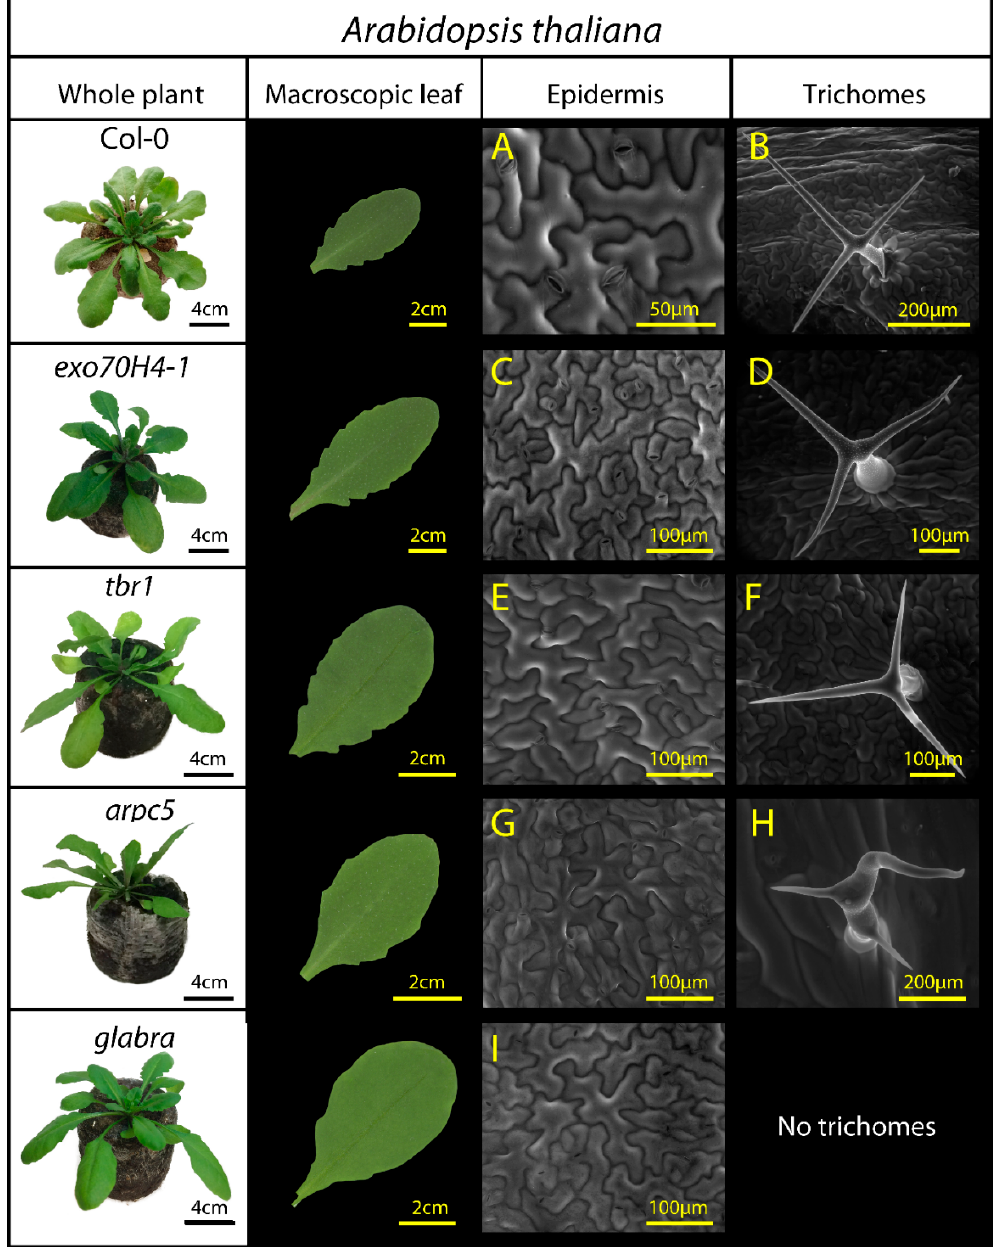
Figure 1. A. thaliana lineages used in the study: Col-0 (wild type), exo70H4-1 , tbr1 , arpc5 , and glabra . Third and fourth columns present epidermal surface observations by environmental scanning electron microscopy, including structure of pavement epidermal cells ( A , C , E , G , I ) and structure of trichomes ( B , D , F , H ), if present. Epidermal mutations are detailed in Table 1.